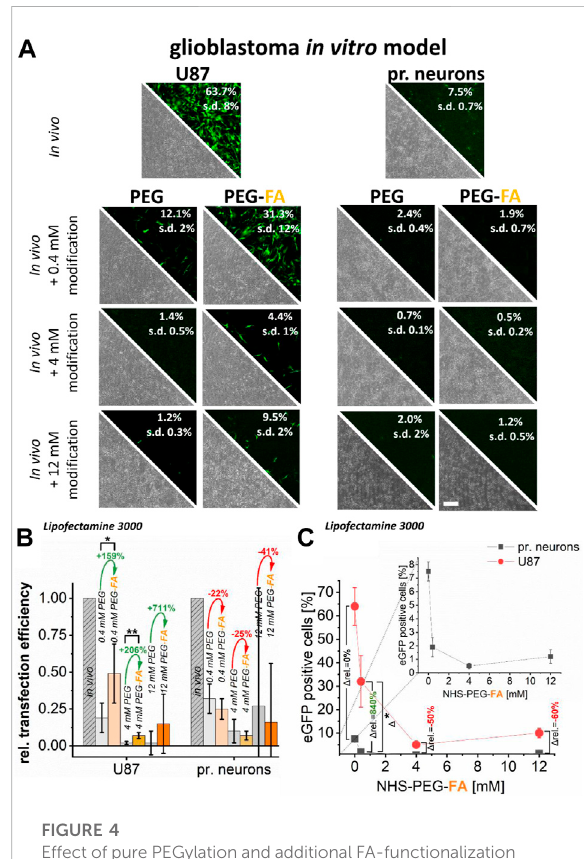
FIGURE 3 Effect of pure PEGylation and additional FA-functionalization on transfer ef fi ciencies. MCF-7 and HFF cells, were transfected witheGFPplasmidusingFuse-ItDNA( invivo protocol).Inaddition, this lipoplexes were further functionalized with PEG and PEG-FA at equal concentrations. Analysis was performed by fl uorescence microscopy and fl ow cytometry (A) . To demonstrate the supplemental effects of FA, relative transfection ef fi ciencies areplottedin (B) andalterationsofmeanvaluesareshowningreen (positive) and red (negative). In (C) , progressions of transfection ef fi ciencies by PEG-FA with improvements in favor of cancer cells (green) and deteriorations (red) are shown. Scale bar 200 μ m. n = at least three independent experiments.